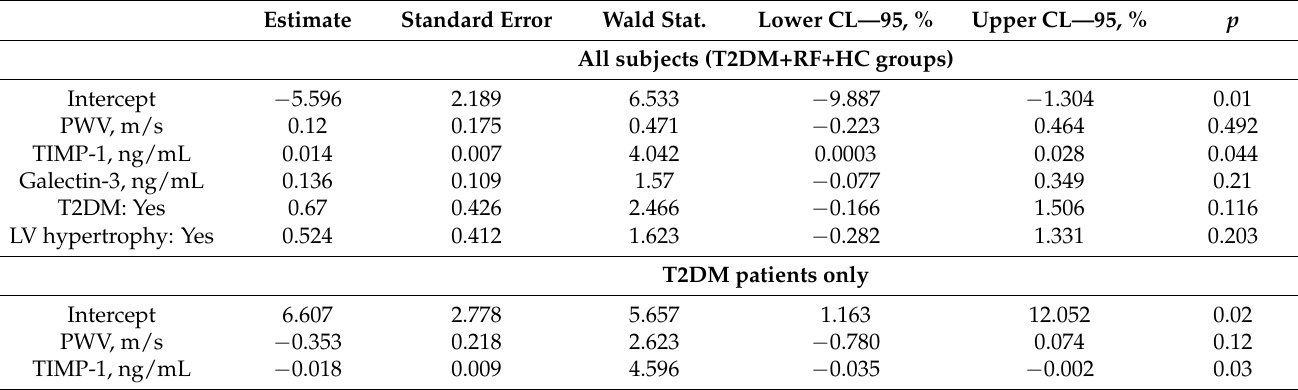
Table 4. General multivariate regression model of cardiac fibrosis predictors (as detected by MRI). Estimate